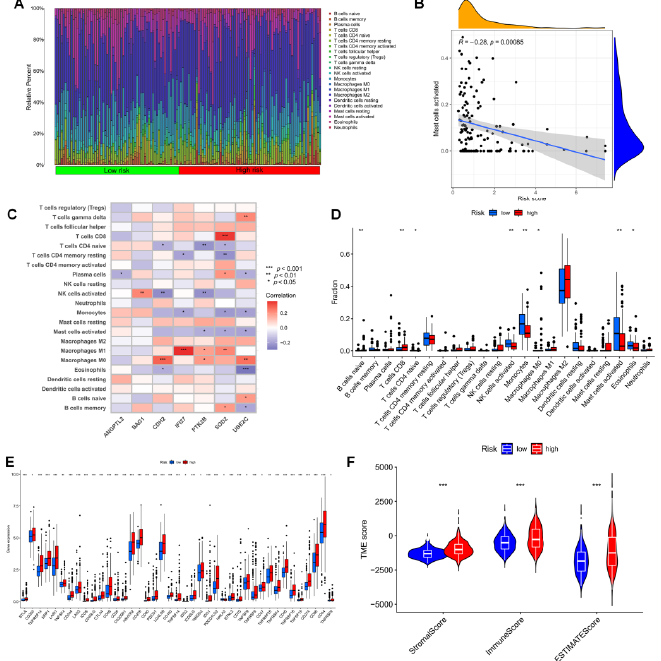
Figure 6. The immune microenvironment of LGG tissues with different risk scores. ( A ) Relative proportions of infiltrating immune cells for different risk subgroups. ( B ) Correlation analysis between risk scores and the proportion of activated Mast cells in LGG tissues. ( C ) Correlation between immune cells and seven hub ANRGs. ( D ) Differences in immune cell composition between the high-risk and low-risk groups. ( E ) Expression of all immune checkpoint genes in the risk group. ( F ) Estimate score of the expression profile in the high-risk group and low-risk group. * p < 0.05, ** p < 0.01, *** p < 0.001.